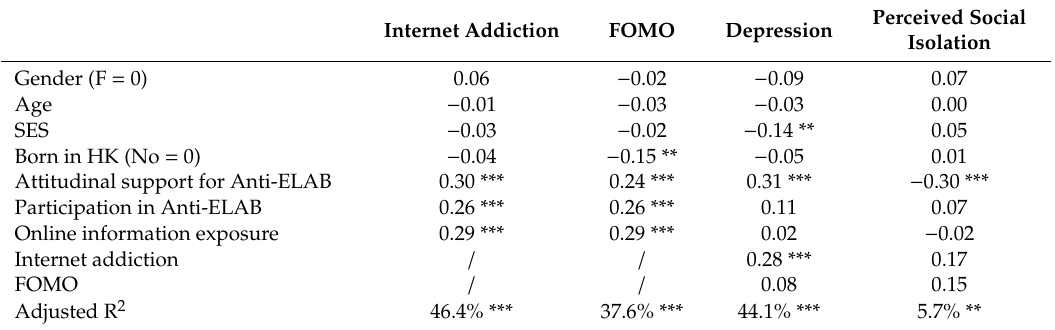
Table 4. Regression analysis for Internet addiction, FOMO, depression, and perceived social isolation.